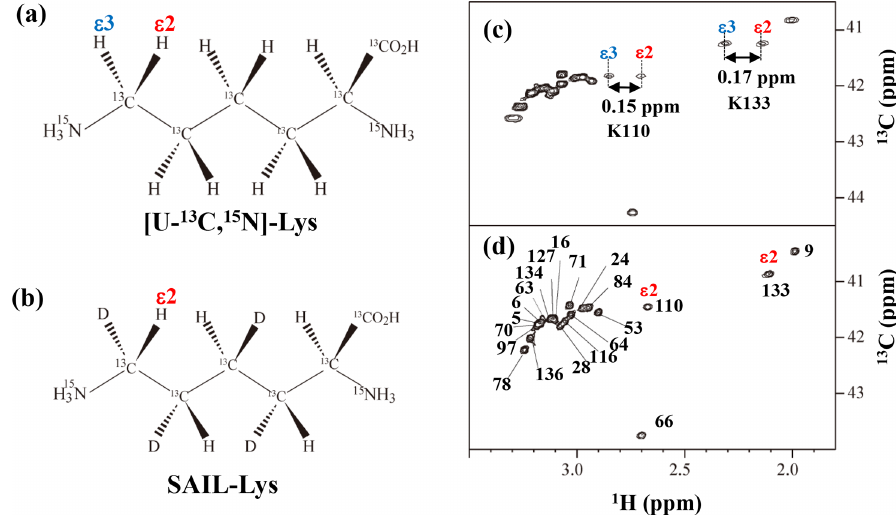
Figure A3. Comparison between the 13 C ε regions of the 2D 1 H– 13 C constant time (ct) HSQC spectra obtained for the SNase variant selectively labeled with [U- 13 C, 15 N]-Lys (a) and [U- 13 C, 15 N; β 2 , γ 2 , δ 2 , ε 3 -D 4 ]-Lys, SAIL-Lys (b) . Since ε -carbons for the [U- 13 C, 15 N]-Lys residues are attached to the two prochiral protons, 1 H ε 2 and 1 H ε 3 , a pairwise correlation signals, namely 1 H ε 2 – 13 C ε and 1 H ε 3 – 13 C ε , can be observed for each of the ε -carbons (c) . However, considerable large chemical shift differences between the prochiral ε -methylene protons were observed only for K110 ( (cid:49)δ , 0.15ppm) and for K133 ( (cid:49)δ , 0.17ppm), and the other 19 Lys residues showed differences less than ∼ 0.05ppm. On the other hand, ε -carbons for the SAIL-Lys residues are attached only to the ε 2-protons, and all of the correlation signals are automatically assigned to 1 H ε 2 (d) . C ε peaks are labeled with their assignment. The spectra were measured at 30 ◦ C on an Avance